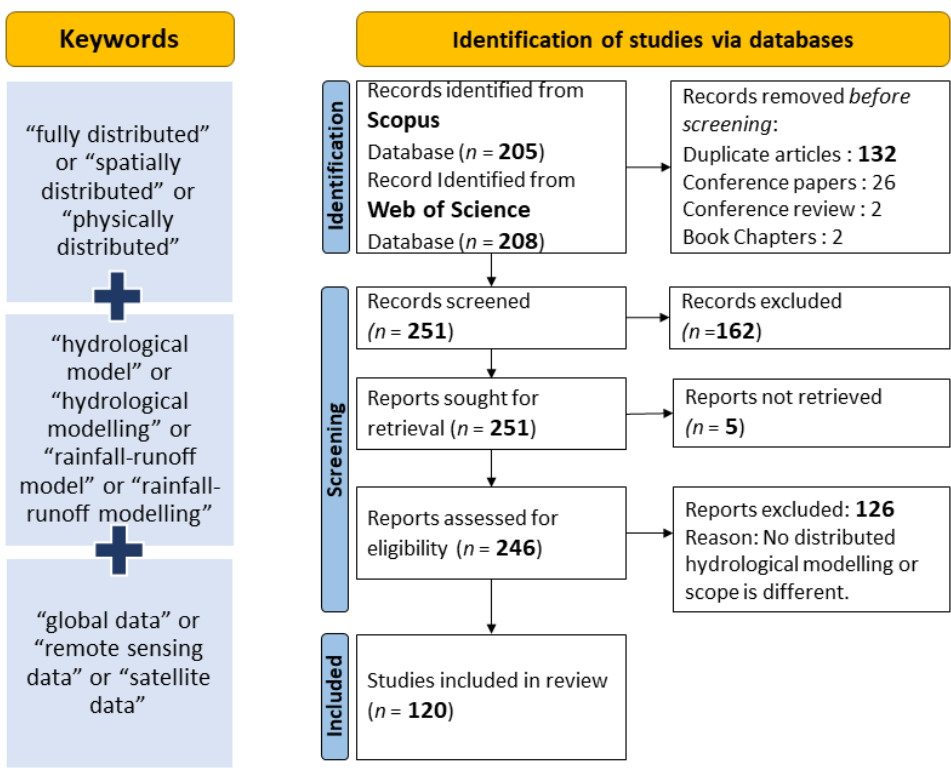
Figure 1. Schematization for identi fi cation of research articles for systematic literature review.